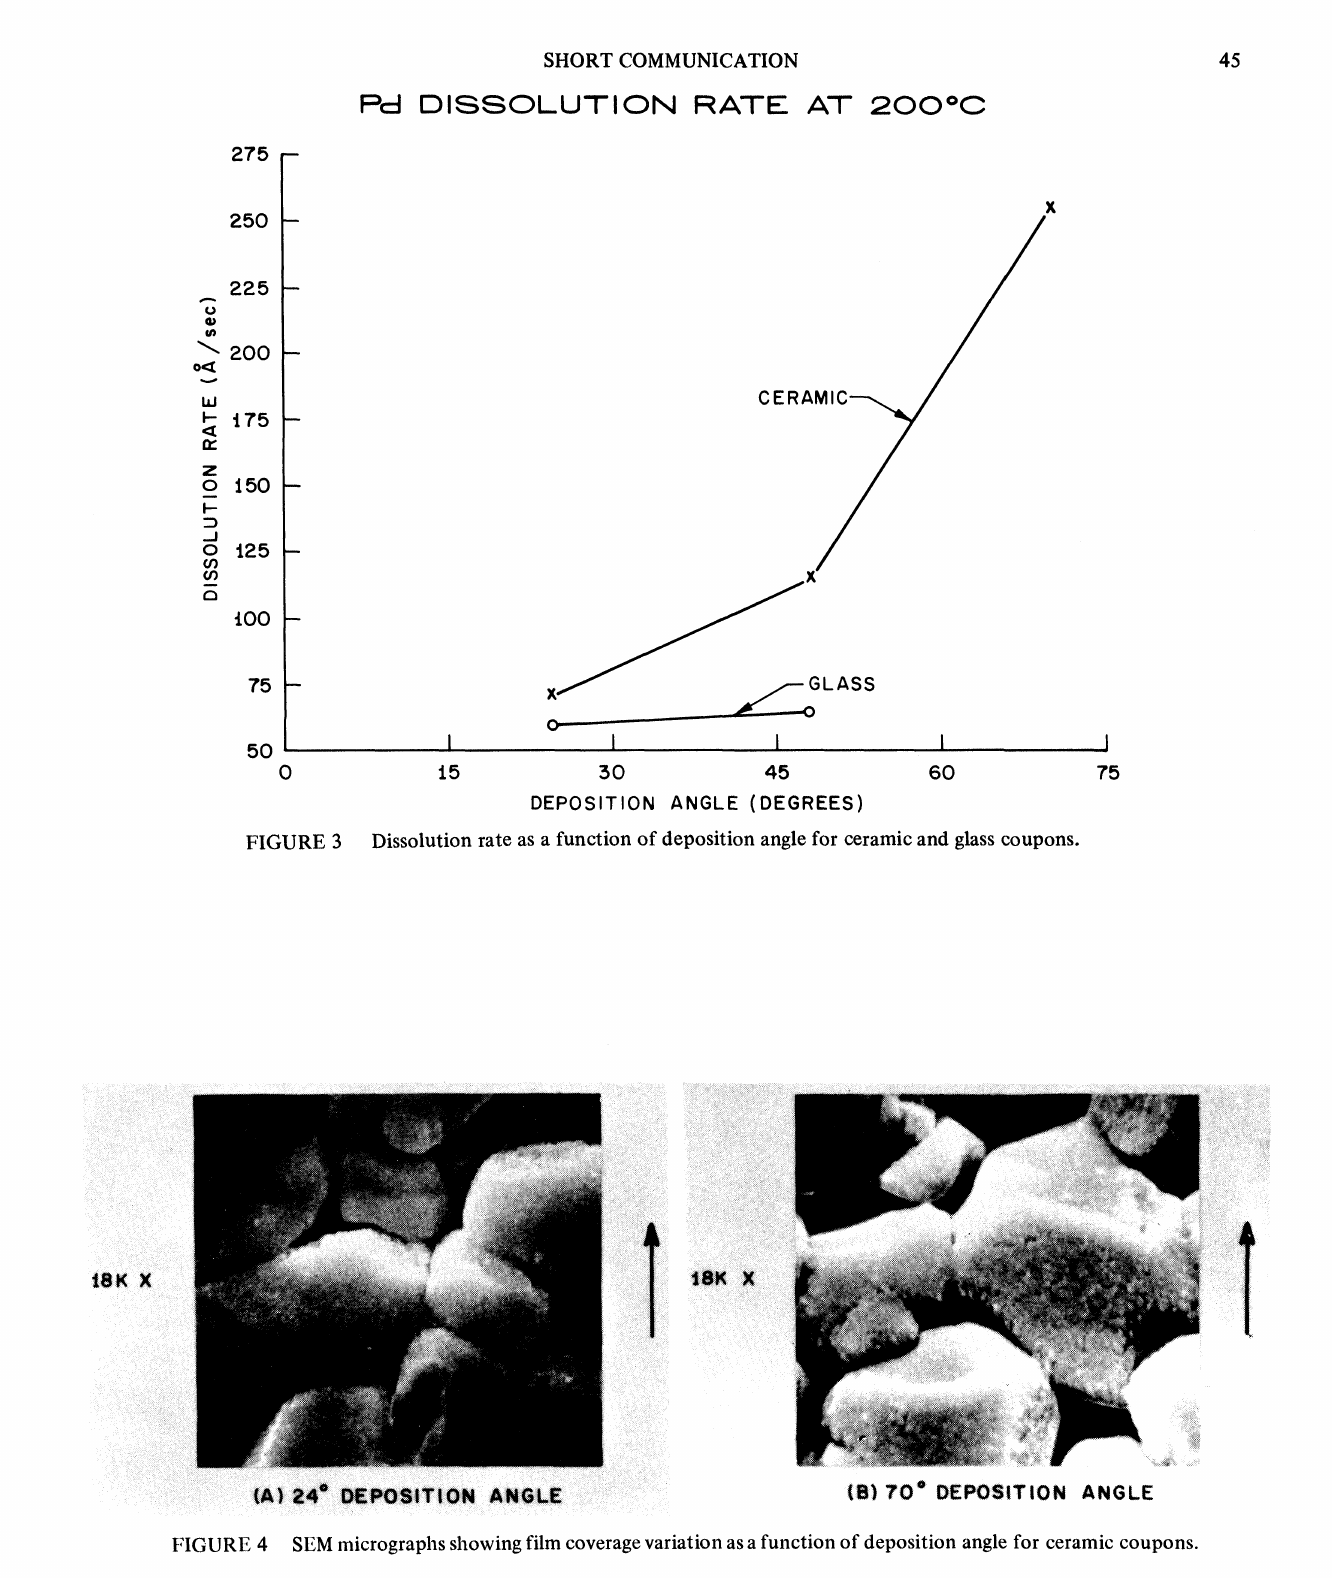
FIGURE 4 SEM micrographs showing film coverage variation as a function of deposition angle for ceramic